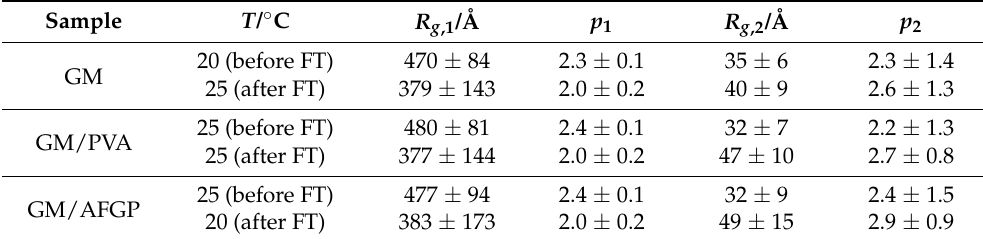
Figure 9. WAXS/SAXS curves for GM/AFGP gels ( a )/( c ) and for GM/PVA ( b )/( d ) gels. Table 1. The result of the fitting